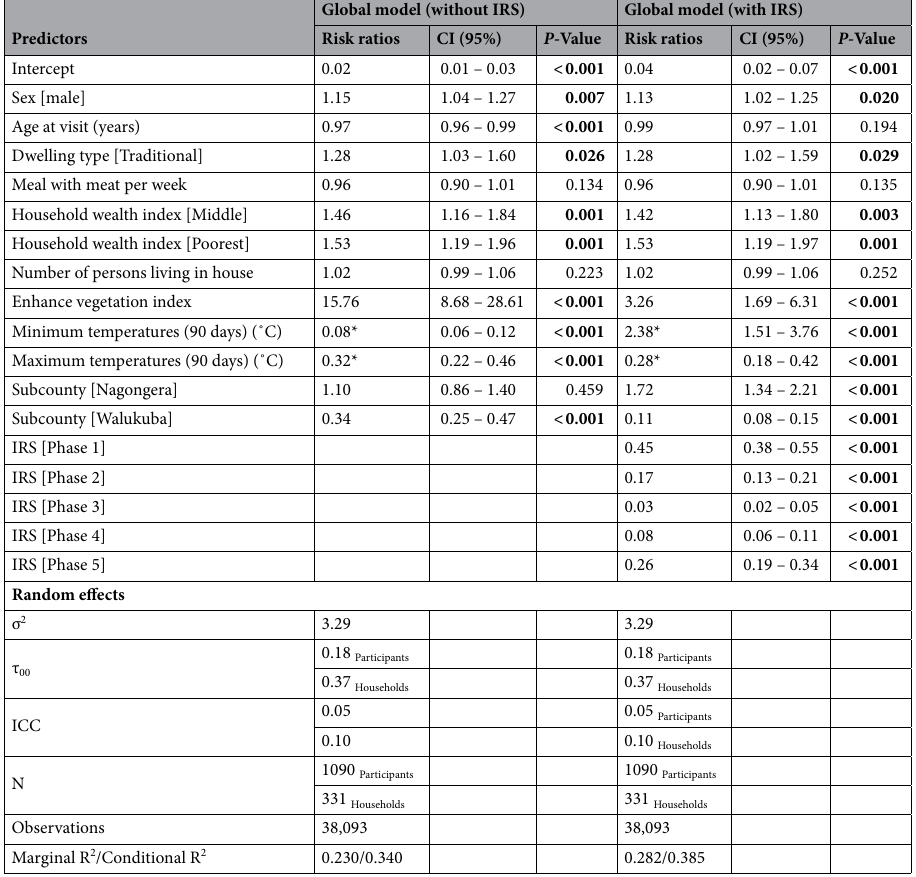
Table 5. Summary of pooled GLMM model with and without IRS. Significant values are in bold. *Risk ratio of malaria when the meteorological linear variable changes from its minimum to its maximum value.